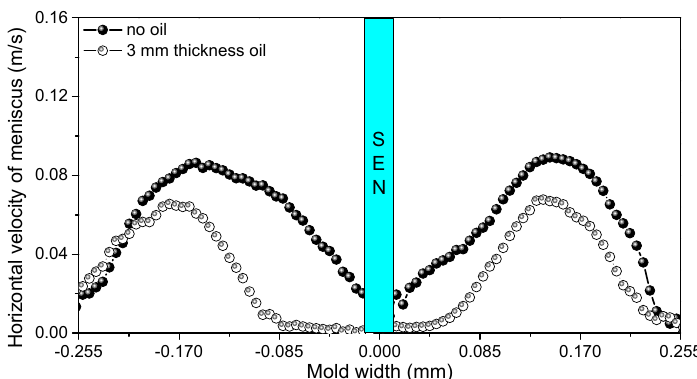
Figure 7. The influence of oil added to the liquid level on the horizontal velocity of the liquid level of the mold.